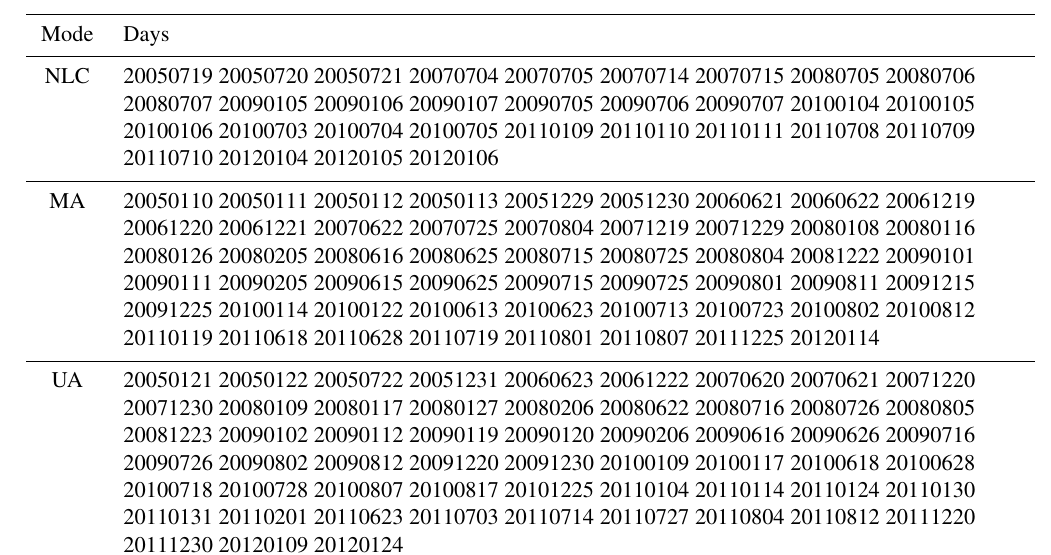
Table 1. Days of MIPAS observations of PMCs in the different modes.